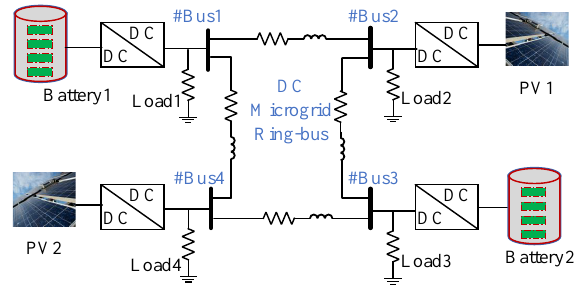
Figure 1. Four-bus DC microgrid with ring